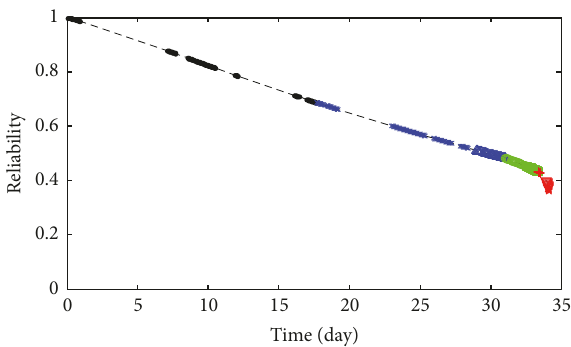
Figure 10: Lifetime reliability (time-dependent